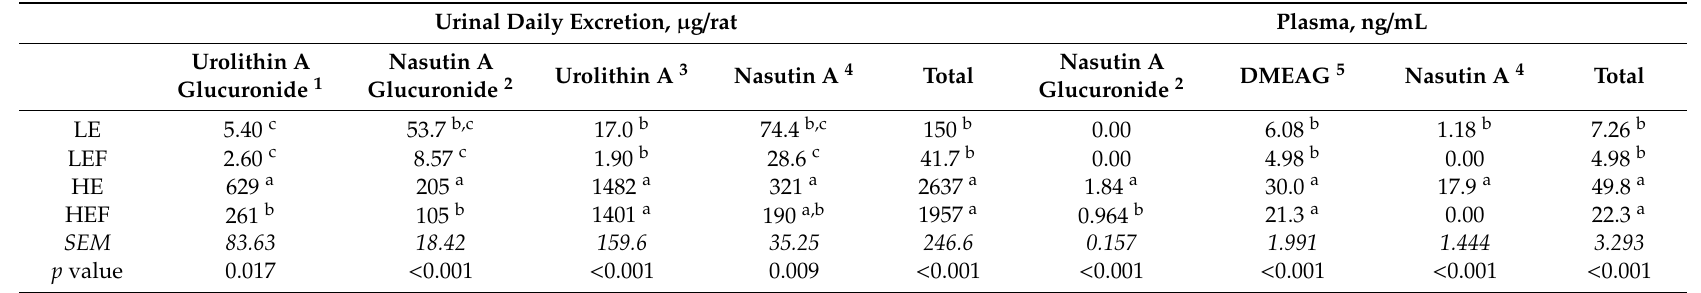
Table 5. Ellagitannin metabolite profile in the urine and plasma of rats fed the experimental diets *. Urinal Daily Excretion, µ g / rat Plasma, ng /